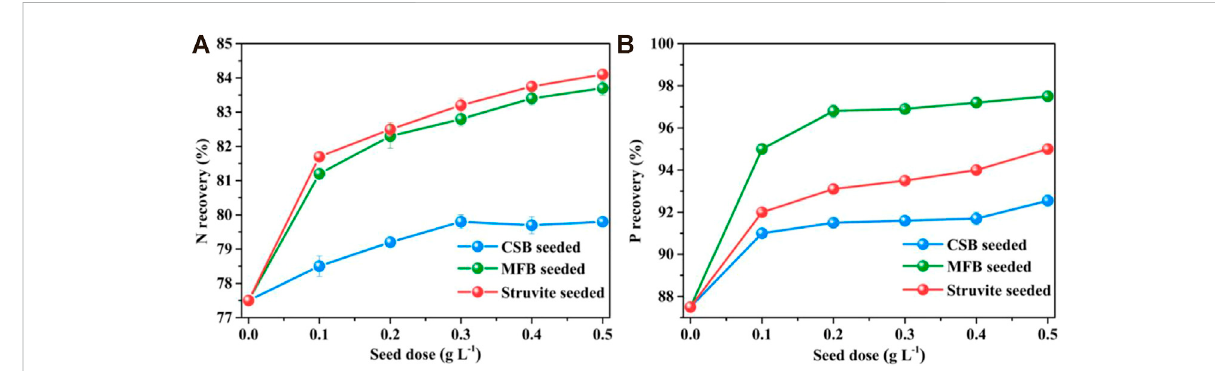
Figure 3. Without seeding, the NH 4 + − N and PO 4 3 − − P recovery ef fi ciency of leachate treated by struvite precipitation are 77.5 and 87.5%, respectively. When seeding materials were added, the nutrient recovery rate was signi fi cantly increased and correlated with the seeding dose positively. The maximum recovery ef fi ciency of NH 4 + − N and PO 4 3 − − P for MFB-seeded (83.7 and 97.5%), CSB- seeded (79.8 and 92.5%), and struvite-seeded (84.1 and 95.0%) processes was obtained at a 0.5 g L − 1 of seeding dose. Under different seeding doses, the NH 4 + − N ef fi ciency of the MFB-seeded process was closed to the struvite-seeded process and was always higher than that of CSB-seeded, while the PO 4 3 − − P ef fi ciency of the MFB-seeded process was alwayshigher thanthat of CSB and struvite- seededprocesses,probablyduetotheadsorption ofPO 4 3 − − PbyMFB. An increasing seeding dose could provide more active growth sites and lead to secondary nucleation, resulting in a higher nutrient recovery ef fi ciency (Frawley et al., 2012).